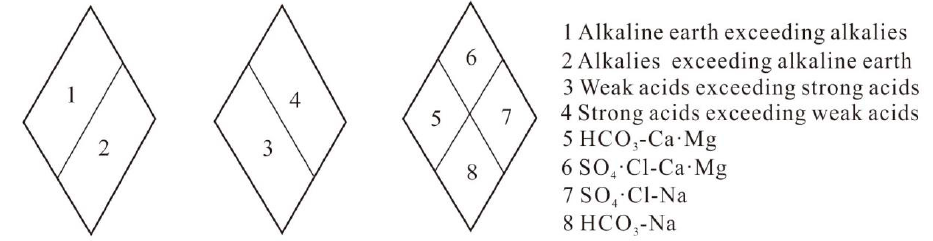
Figure 4. Piper trigram diamond-shaped hydrogeochemical map.